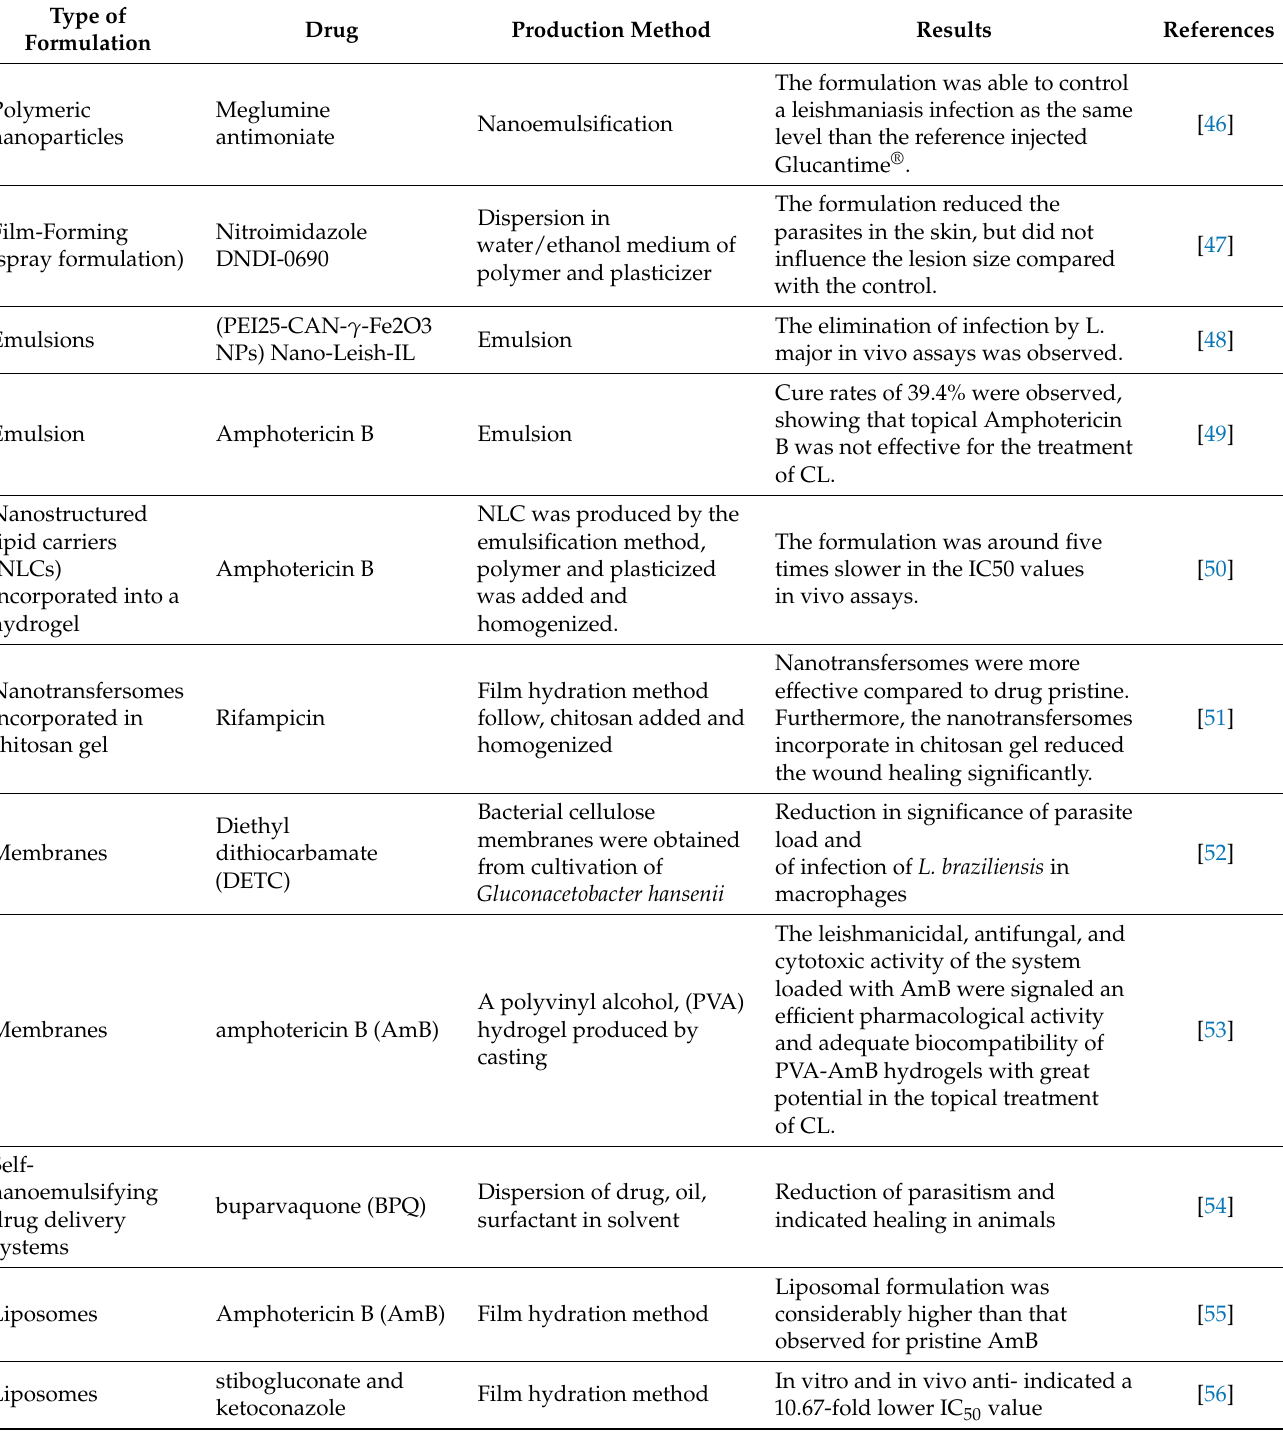
Table 2. Examples of formulations proposed for cutaneous leishmaniosis, type of drug, production method and main